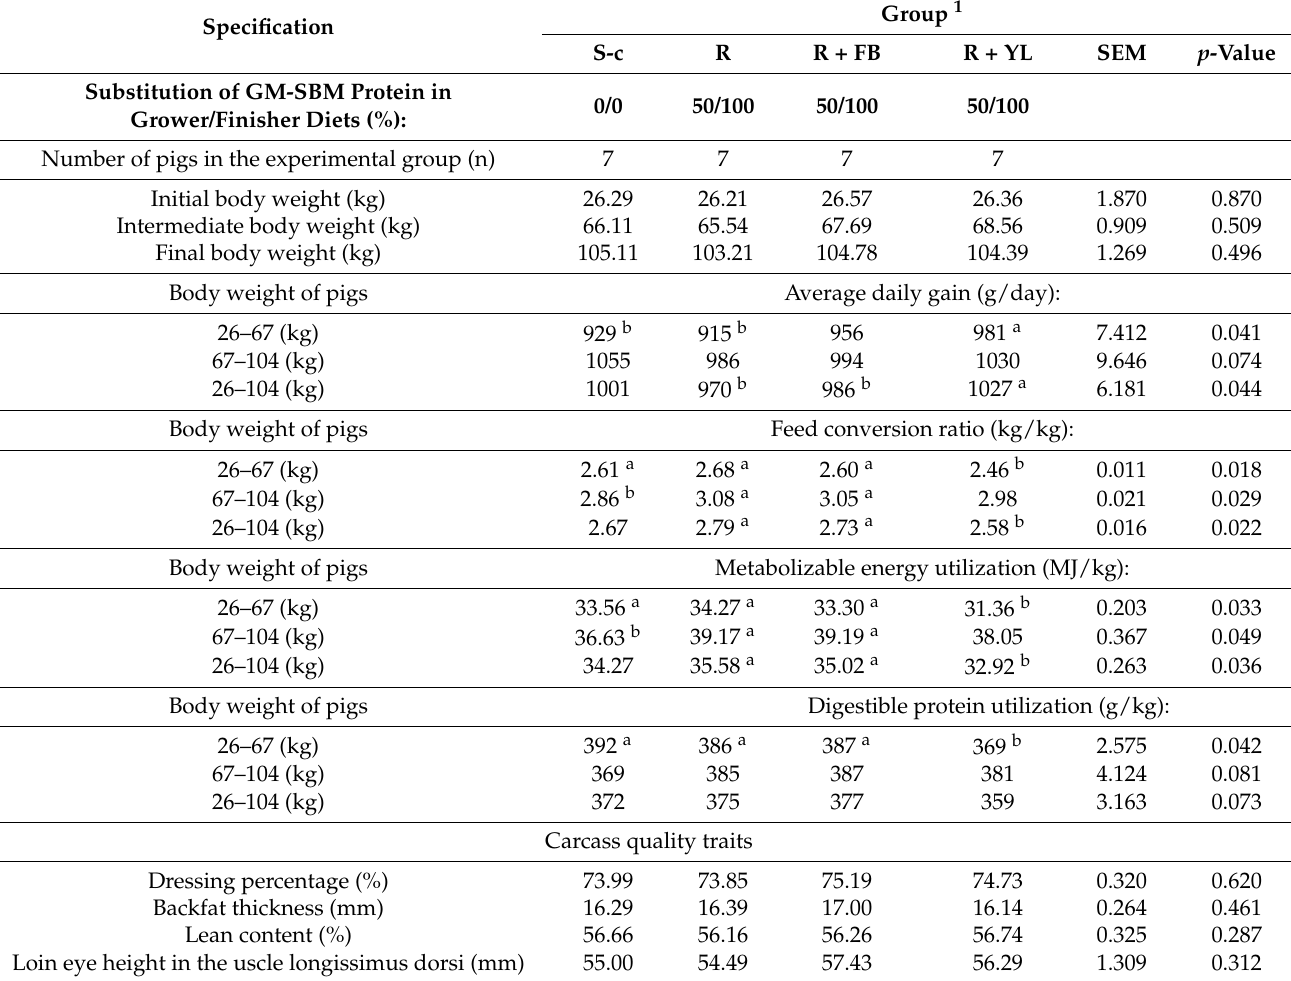
Table 6. Fattening performance and carcass quality traits in growing-finishing pigs (Experiment